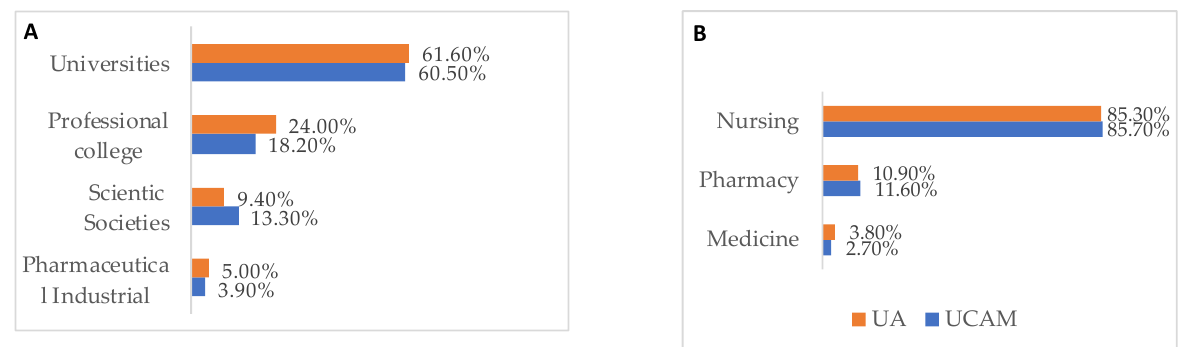
Figure 2. Sources of information about vaccines.